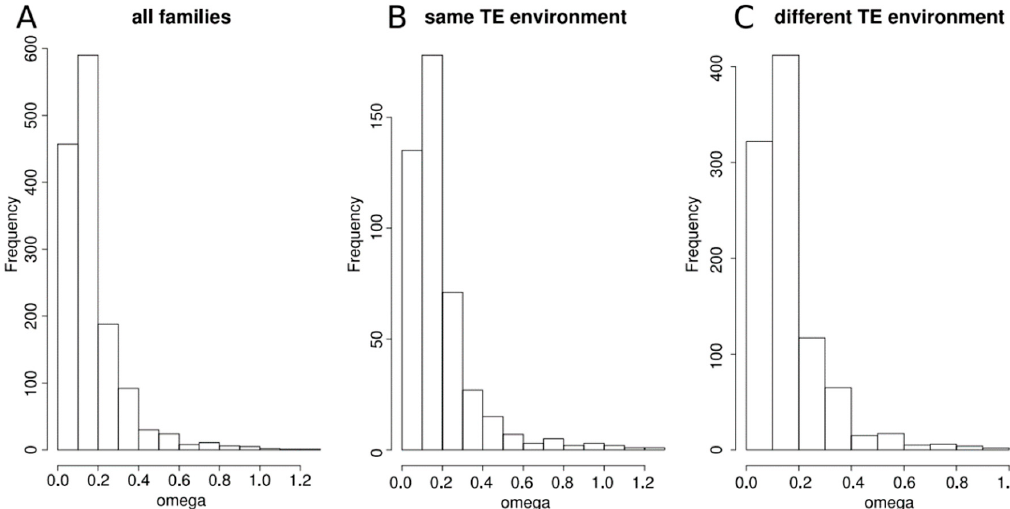
Figure 1. Distribution of the omega (dN/dS) ratio computed between duplicated genes from a same family, ( A ) for all families, ( B ) for families whose two genes have the same transposable elements (TE) environment, ( C ) for families whose two genes have different TE environment.